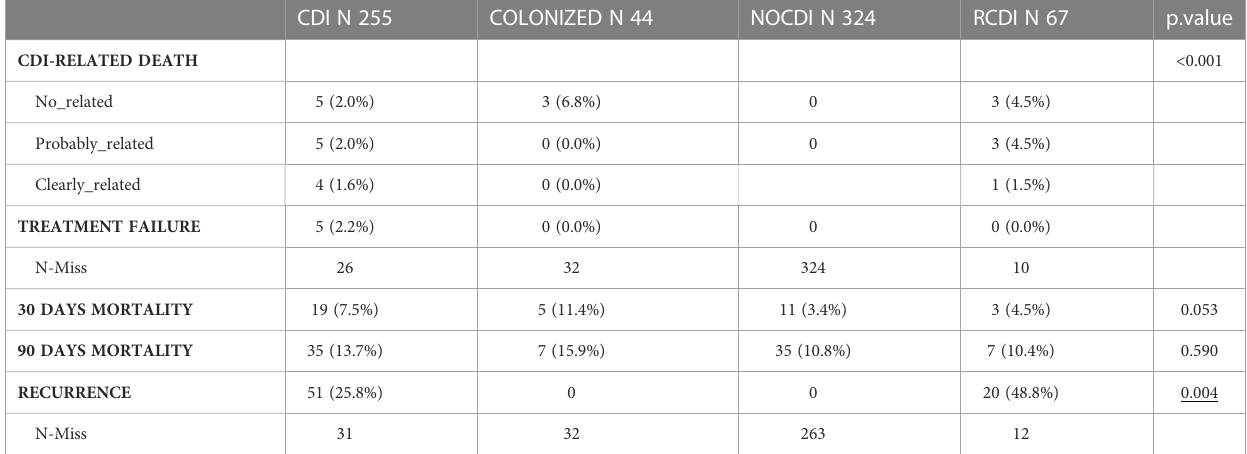
TABLE 3 Patients ’ evolution after sample collection.